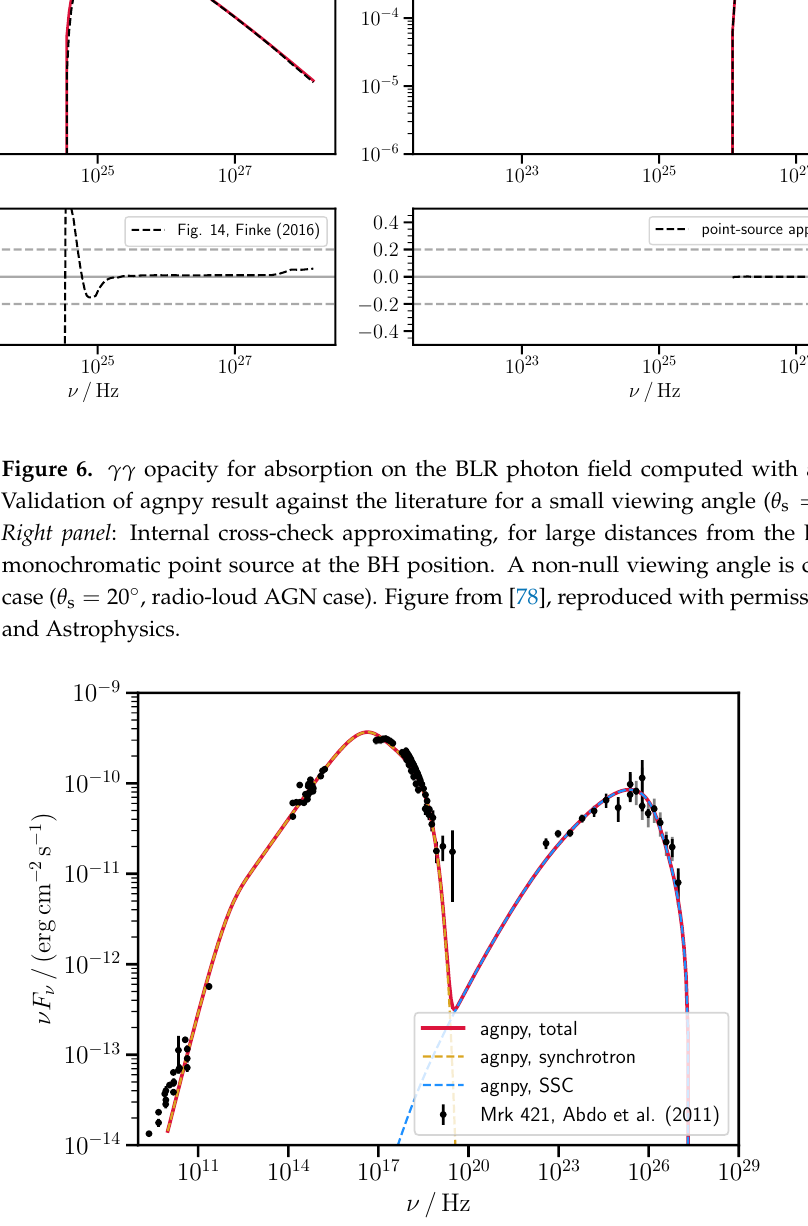
Figure 7. Fit of the MWL SED of Mrk 421 observed in [87], obtained wrapping the radiative provided by agnpy within the classes for flux points handling and model fitting in Gammapy. Figure from [78], reproduced with permission of Astronomy and